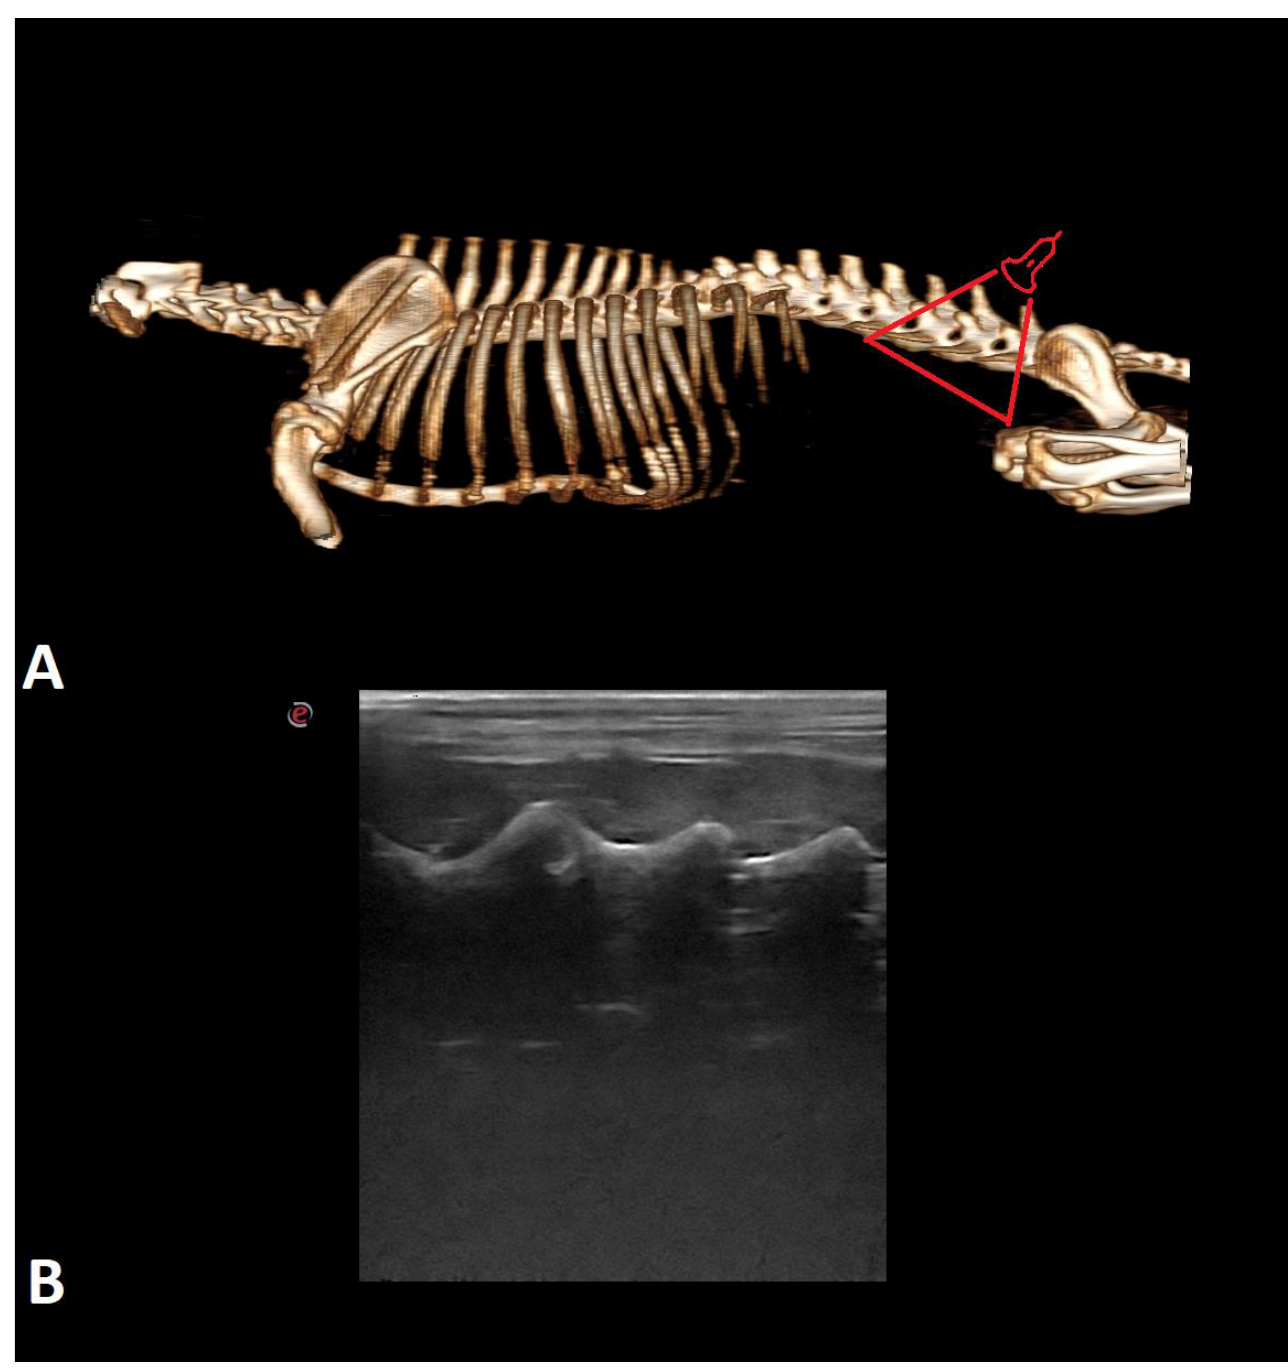
Figure 3. The 3D CT scan ( A ) and ultrasonographic image of the longitudinal paramedian plane on the dorsal side ( B ) of the lumbar spine of the dog. The red triangle indicates the place on the spine where the probe was applied.